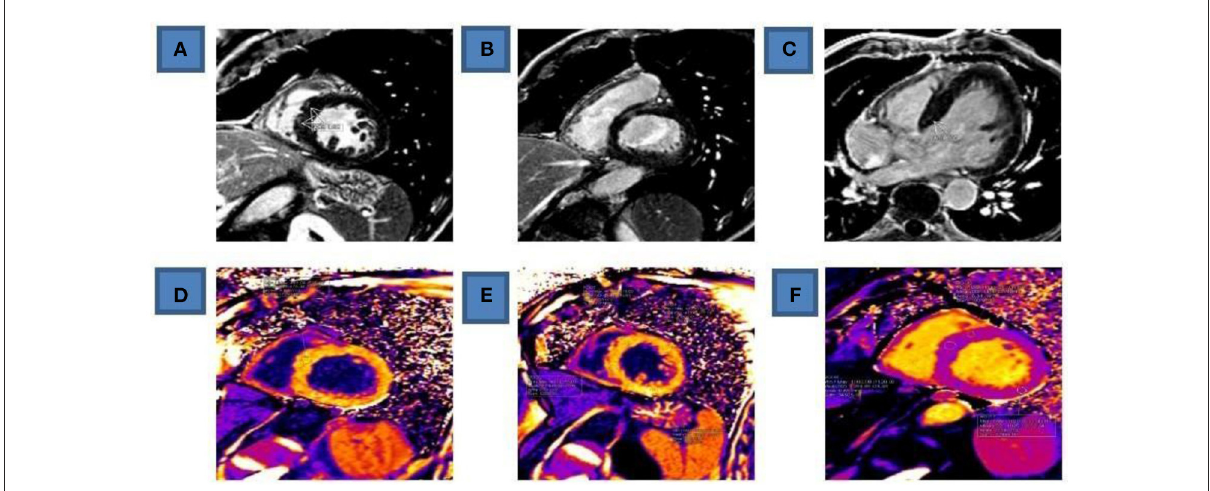
FIGURE3 CMR of the heart (Fifth day of admission). (A) Postcontrast LGE in medial septum on PSIR sequence, SAX. ( B) Basal anteroseptal postcontrast LGE on PSIR sequence, SAX. (C) Basal septum LGE phenomenon as well as pericard LGE in basal and medial lateral wall on PSIR sequence, four chamber view. (D) Pathological postcontrast T1 mapping (values > 500ms) in basal septum, on MOLLI sequence, SAX. ( E) Pathological postcontrast T1 mapping (values > 500ms) in medial segments of all walls, circumferentially, on MOLLI sequence, SAX. (F) Pathological